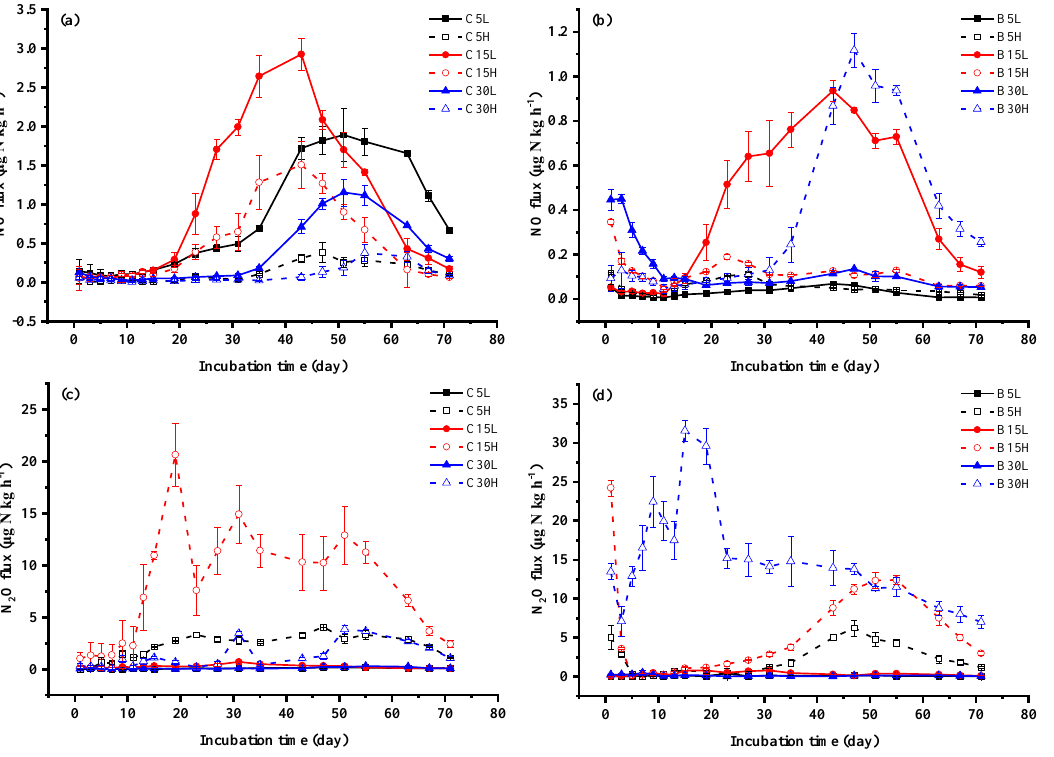
Figure 4. Soil NO (a,b) and N 2 O (c,d) fluxes during 71-day incubation period in (a, c) Changsha tea field Figure 4. Soil NO ( a , b ) and N 2 O ( c , d ) fluxes during 71-day incubation period in ( a , c ) Changsha tea field soil, and Baisha tea field soil ( b , d ). L: 50% WFPS, H: 80% WFPS; 5, 15, and 30 represent soil soil, and Baisha tea field soil (b, d). L: 50% WFPS, H: 80% WFPS; 5, 15, and 30 represent soil under 5-y, under 5-y, 15-y, and 30-y tea plantations. Error bars indicate standard 15-y, and 30-y tea plantations. Error bars indicate standard deviation.